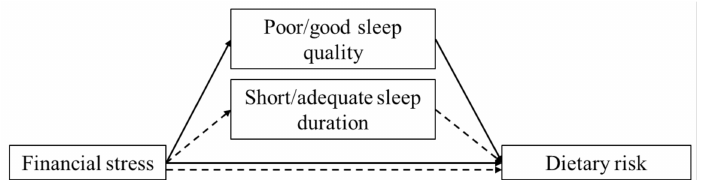
Figure 1. Proposed mediation models. The effects of financial stress on dietary risk scores through the mediation of sleep quality among poor sleepers (mediation model 1, solid line) or good sleepers (mediation model 3, solid line). The effects of financial stress on dietary risk scores through the me- diation of sleep duration among students who reported short sleep duration (mediation model 2, dashed line) or students who reported adequate sleep duration (mediation model 4, dashed